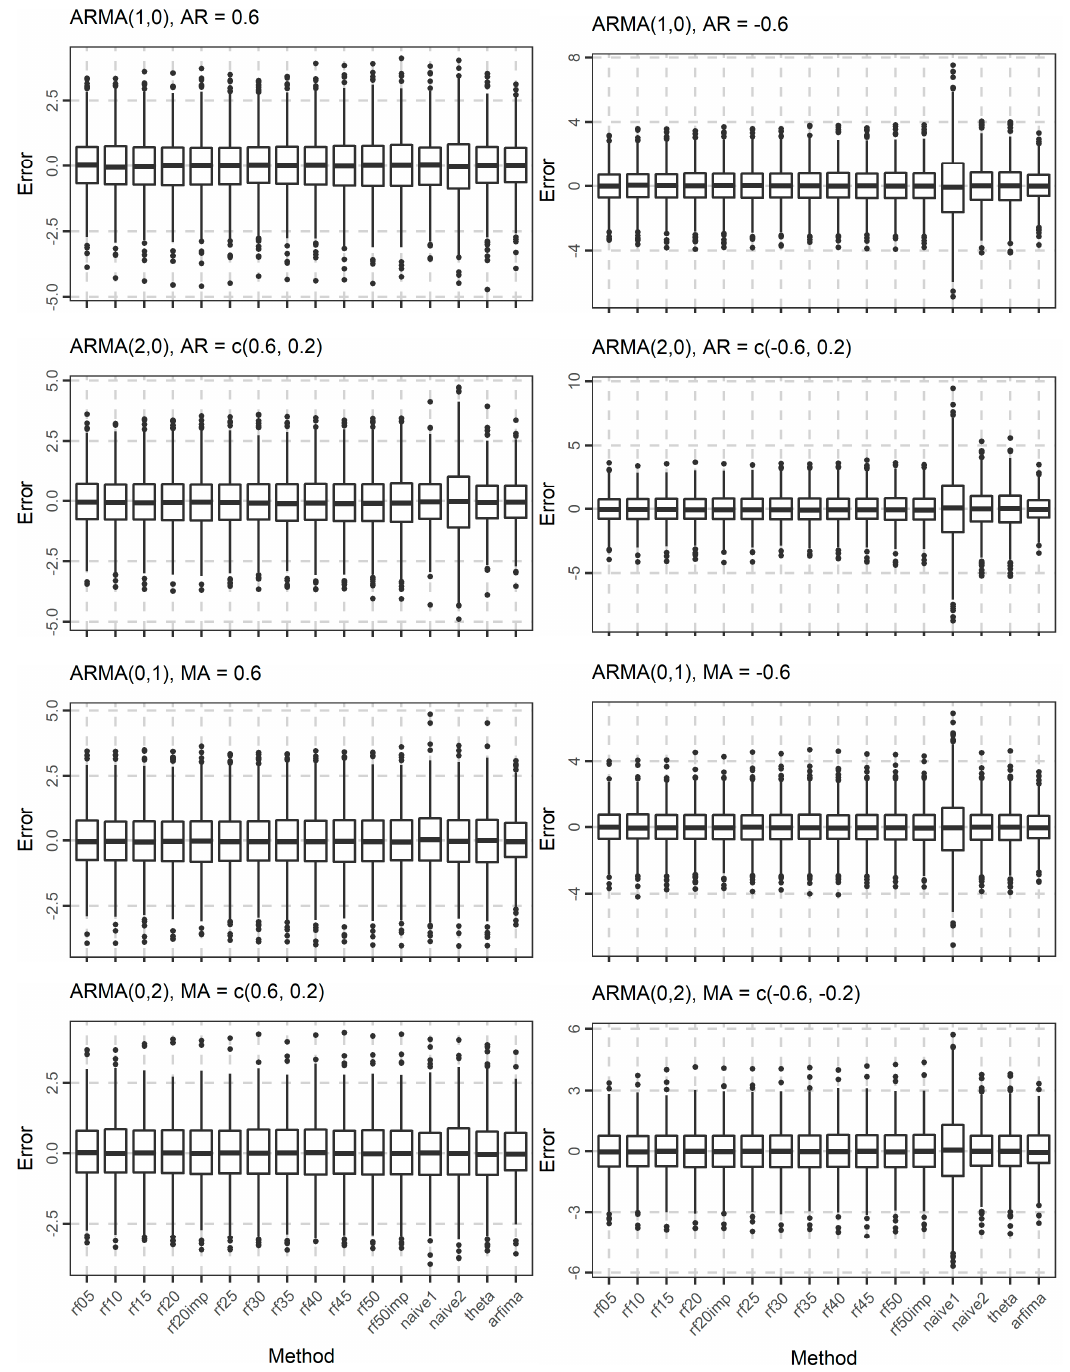
Figure 7. Boxplots of the errors when forecasting the 101st value of 1000 simulated time series from each ARMA( p , 0) and ARMA(0, q ) model used in the present study.